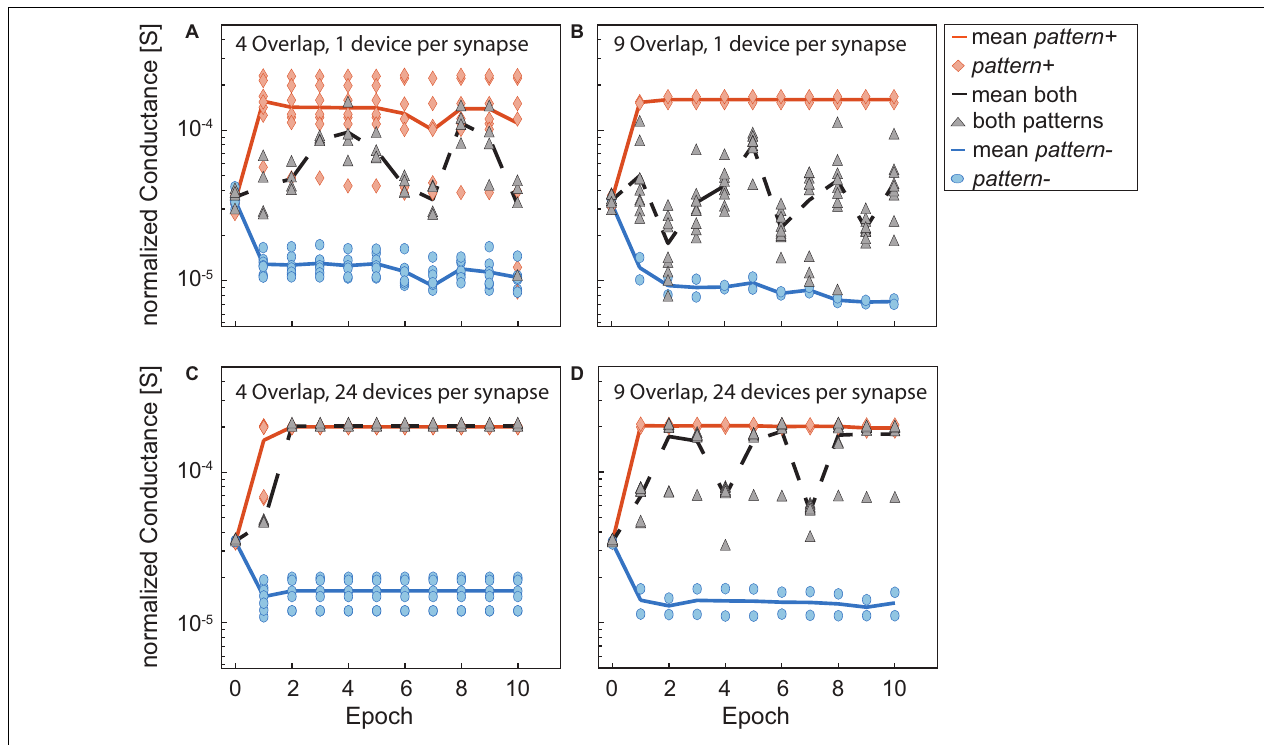
FIGURE 12 | (A–D) Show the conductances normalized to the number of devices per synapse of the synapses receiving pattern+ (orange line and diamonds), pattern- (blue line and circles) and both patterns (black line and gray triangles) over the training epochs. The solid and dashed lines show the mean values while the different symbols show the values of the actual